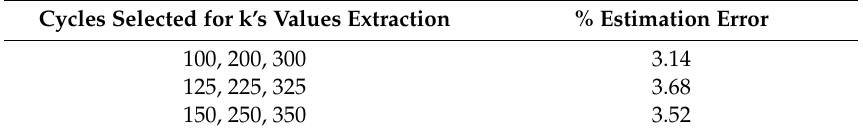
Table 6. Percentage estimation error of SoH for a di ff erent set of three cycles in the k’s values extraction. Cycles Selected for k’s Values